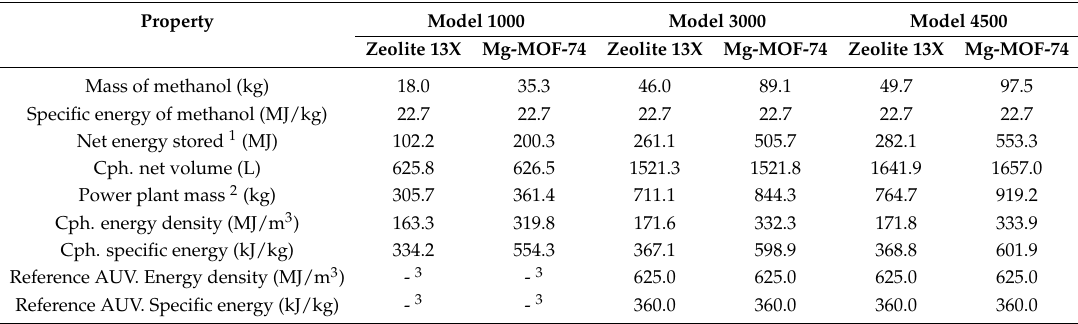
Table 6. Energy stored by the DMFC-AUV. LHV of methanol from [14]. Reference AUV energy data from